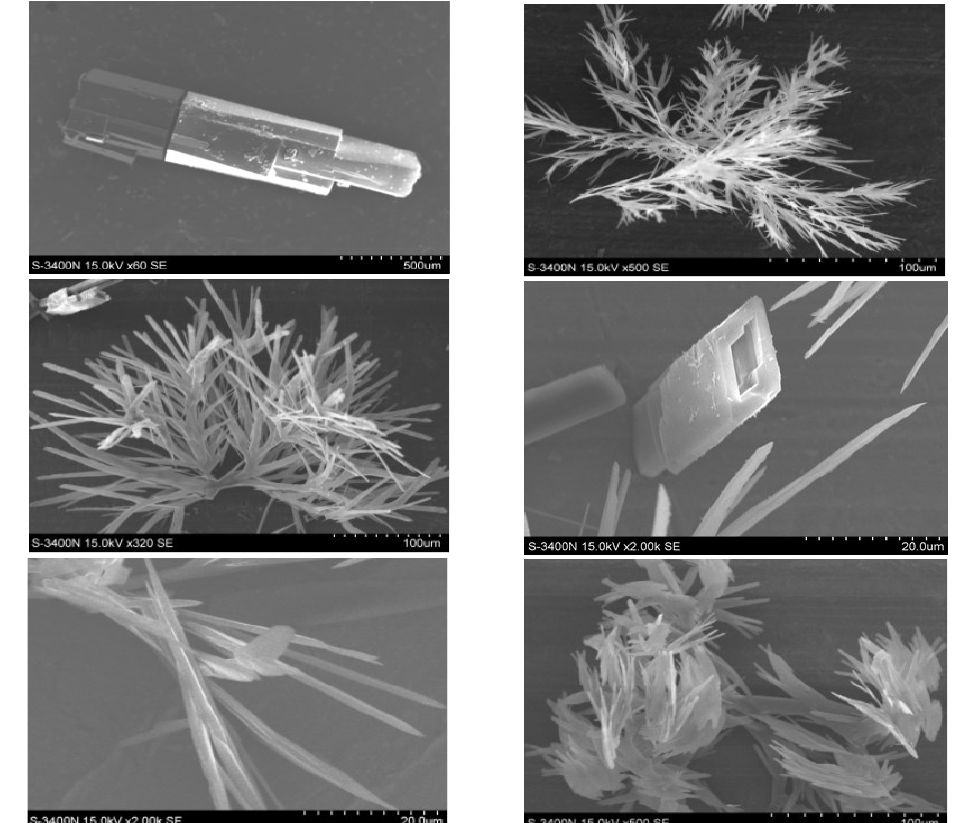
Fig. 4. The SEM micrographs of unprocessed and processed curcumin crystal by SEDS process (a) Separating purified crystals of curcumin (b) T = 309 K, C 0 = 2.0 mg / mL, V L = 2.0 mL / min, P = 12 MPa; (c) T = 309 K, C 0 = 3.0 mg / mL, V L = 2.0 mL / min, P = 12 MPa; (d) T = 313K, C 0 = 2.0 mg / mL, V L = 2.0 mL / min, P = 12 MPa; (e) T = 309 K, C 0 = 2.0 mg / mL, V L = 1.0 mL / min, P = 12 MPa; (f) T = 313 K, C 0 = 2.0 mg / mL, V L = 2.0 mL / min, P = 10